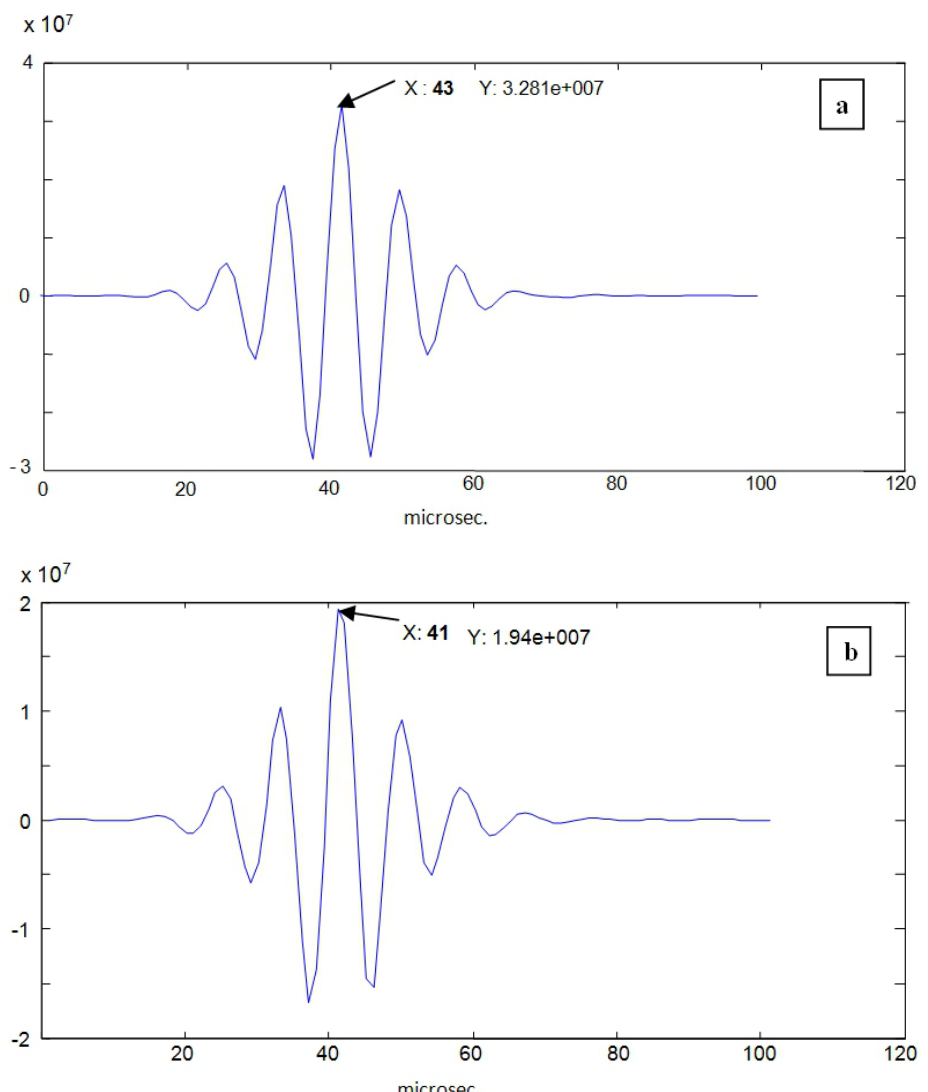
Figure 12. Cross-correlation of echoes in the A-Scans number 26 and 38,